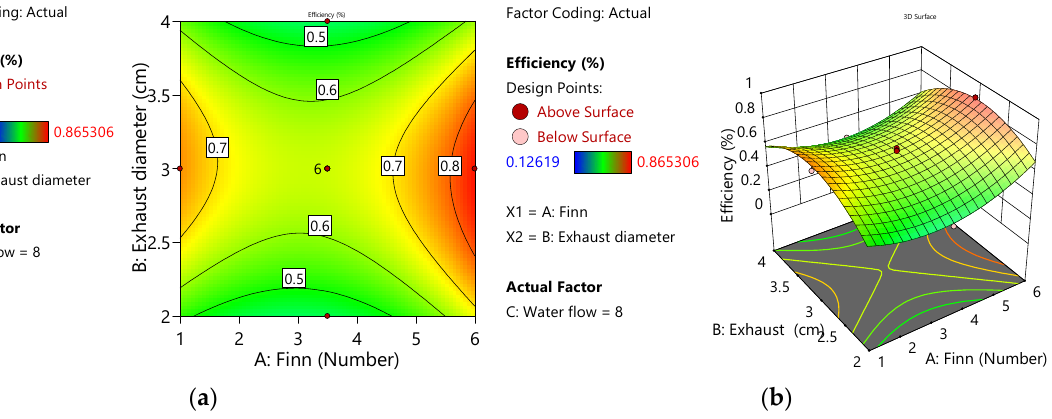
Figure 3. ( a ) Response surface representing e ffi ciency as a function of fi n number and WFR, and ( b ) contour lines representing e ffi ciency as a function of fi n number and WFR.